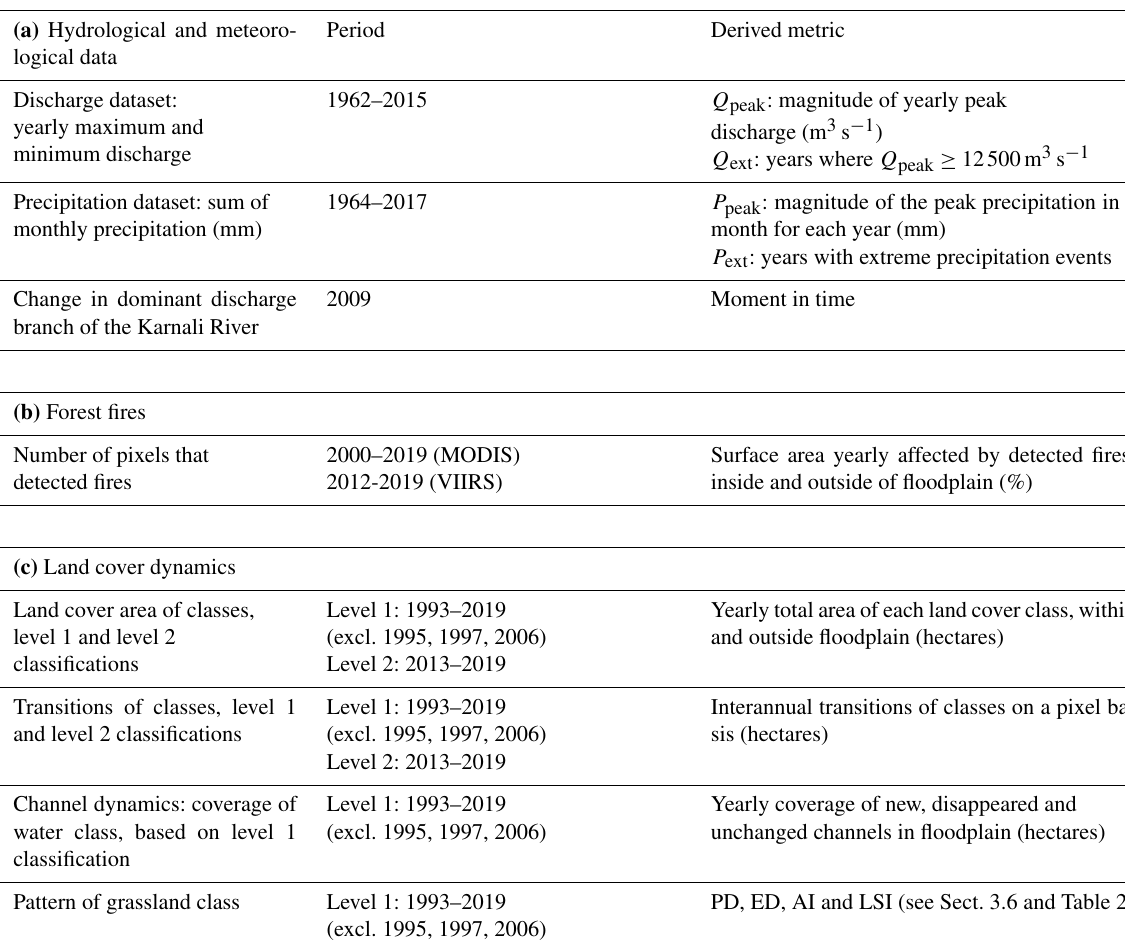
Table 1. Datasets of the environmental drivers (a, b) and land cover dynamics (c) , the derived metrics, and their time span. (a) Hydrological and